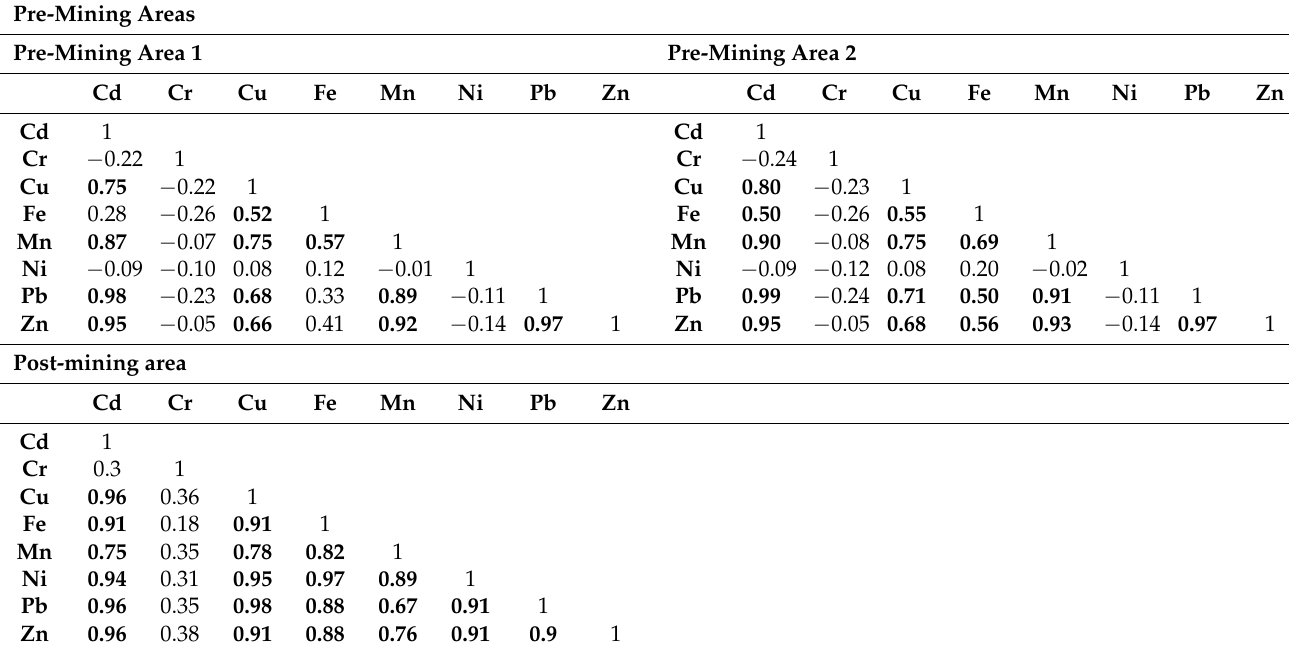
Table 4. Pearson correlation matrix for heavy metal in soil